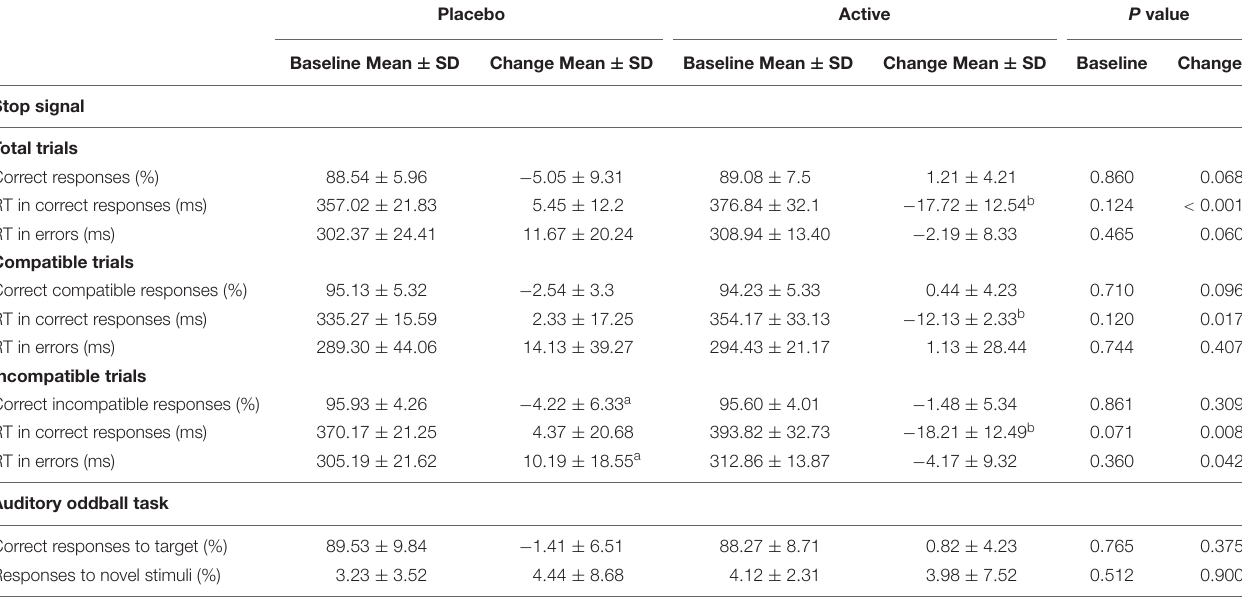
TABLE 2 | Behavioral performance in the Stop-signal task and in the Auditory oddball task at baseline and endpoint.